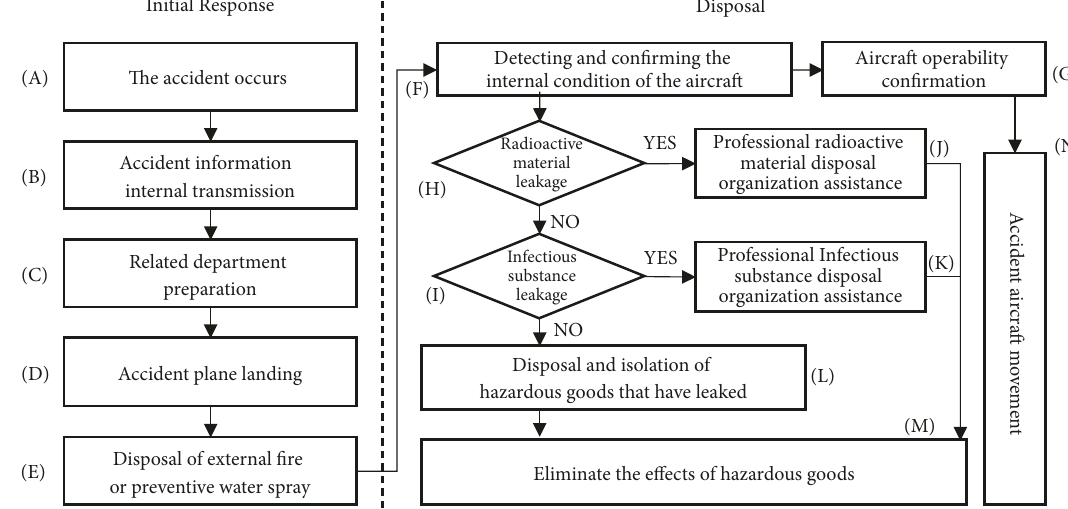
Figure 2: Emergency response process in the emergency response